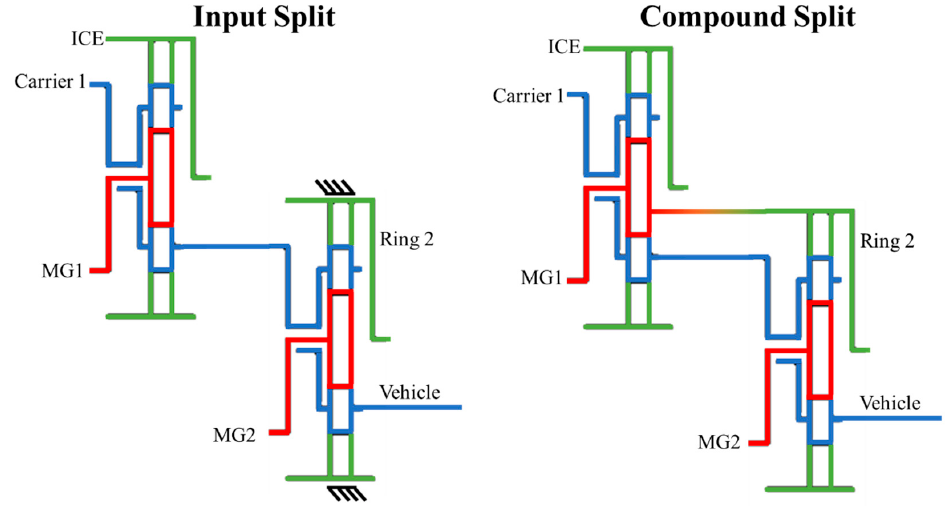
Figure 2. Scheme of the two powertrain modes: Input Split (left) and Compound Split (right).